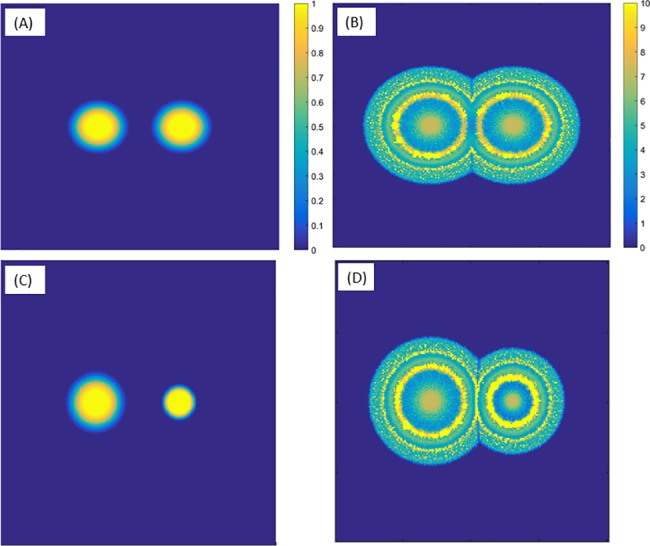
Simulation results with two colonies (P. vortex+E. coli).Left: Initial colonies. Right: After 30 hrs. Upon contact, the builder/explorer phases of the two colonies synchronize.